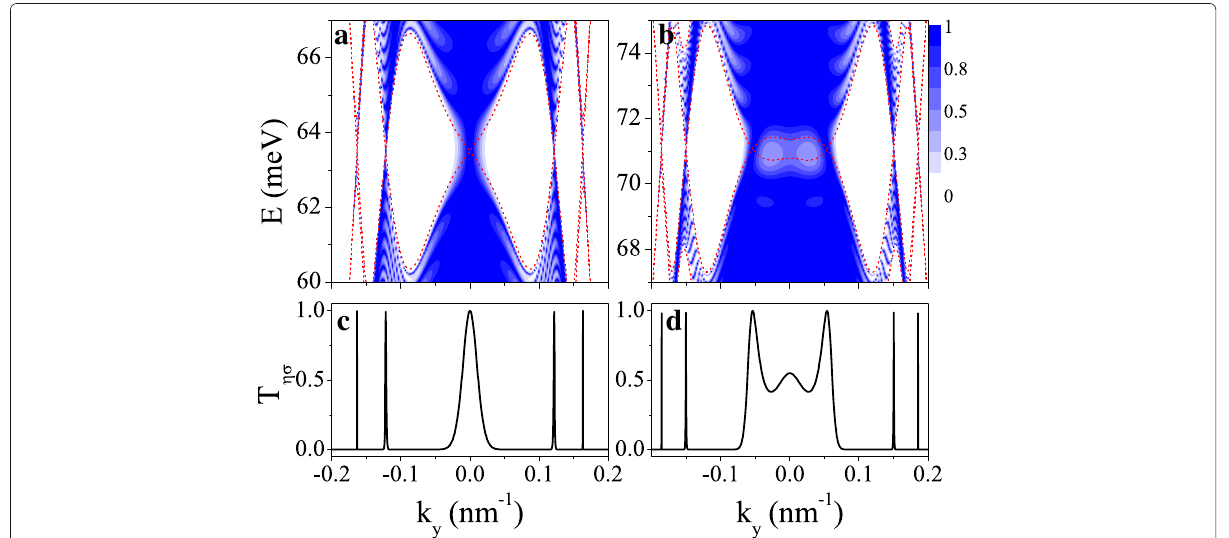
Fig. 7 Contour plot of the transmission T ησ ( E , k y ) for ( a ), ( c ) K ↑ electron and ( b ), ( d ) K ↓ electron. The values of parameters are the same as these in Fig. 2 (d1–d4), and n =